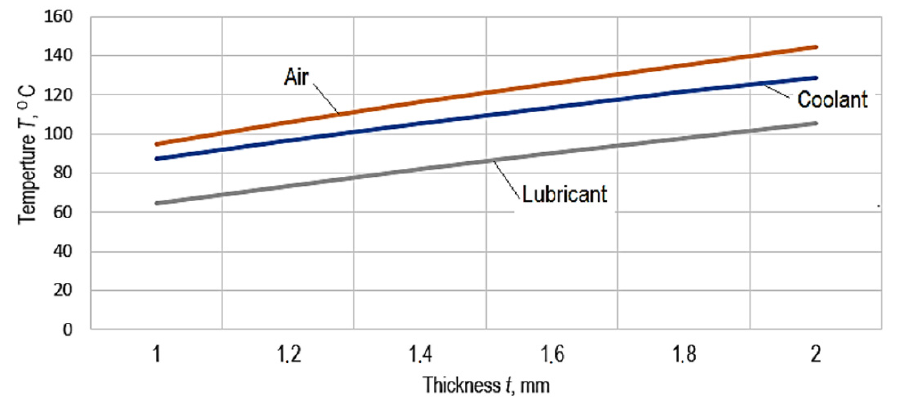
Figure 9. Influence exerted by the workpiece thickness t on the sample when using a coolant, air and lubricant temperature ( f = 1500 mm/min, s d = 0.5 mm).